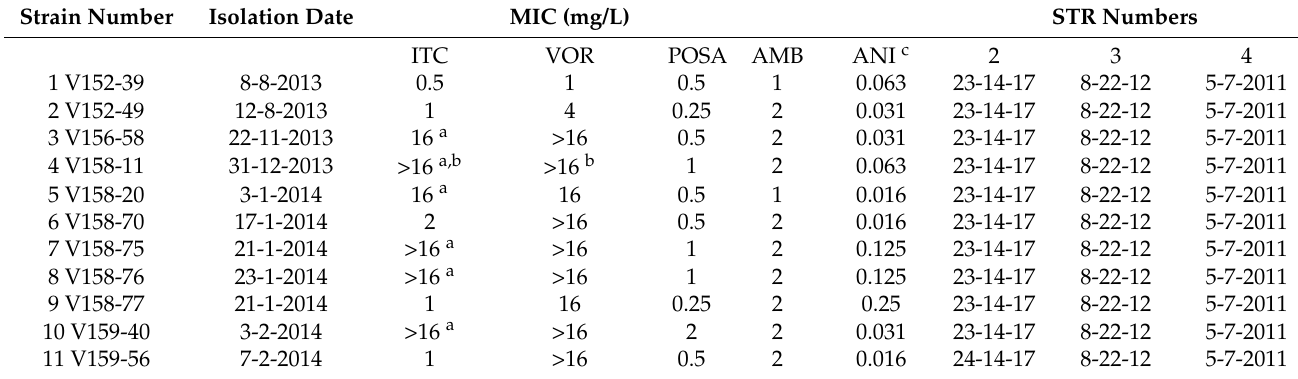
Table 1. Overview susceptibility and short tandem repeat (STR) typing of 11 sequentially cultured A. flavus isolates MIC minimal inhibitory